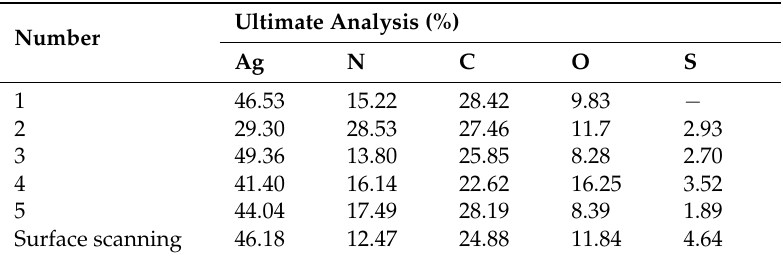
Table 5. Ultimate analysis of TSC-CC resin loaded Ag + from EDS.